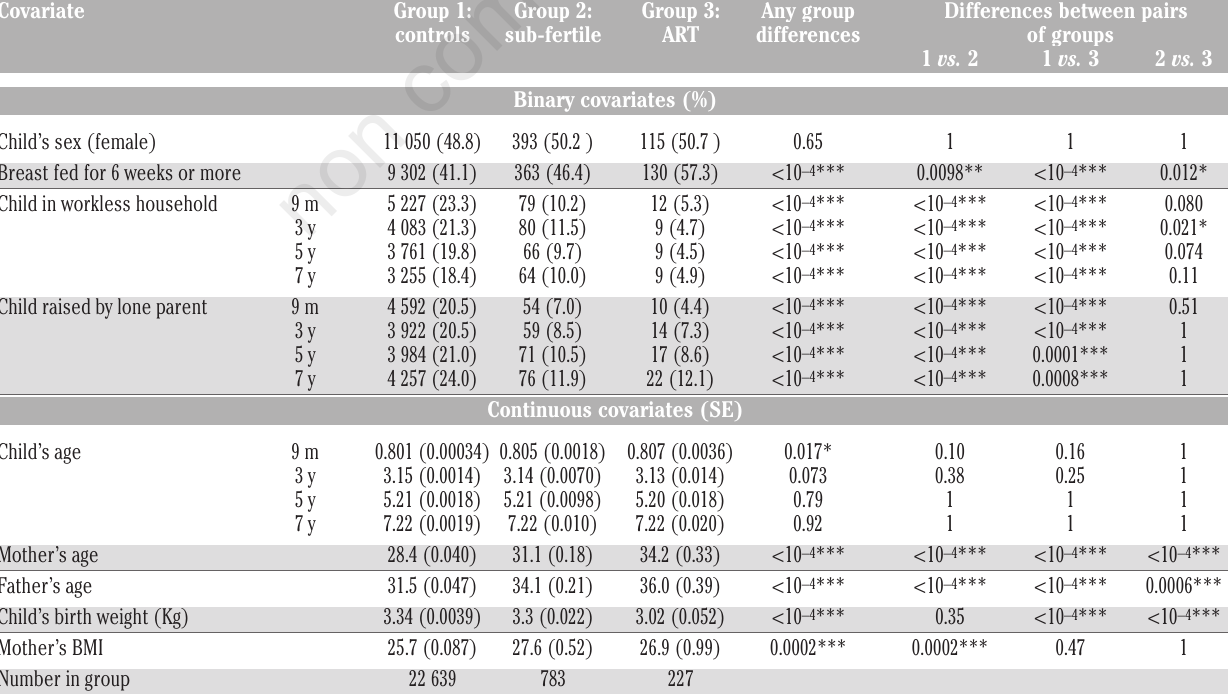
Table 3. Summary of comparisons of binary and continuous covariates by group. For the binary variables, numbers of cases are given, with the percentage of the group this represents in brackets. For the continuous variables, group means are given with their standard error in brackets. The P for an ANOVA test for group differences is shown, along with the P for tests for differences between each pair of groups, using a Bonferroni correction to maintain the Type I error rate of 5%. Covariate Group